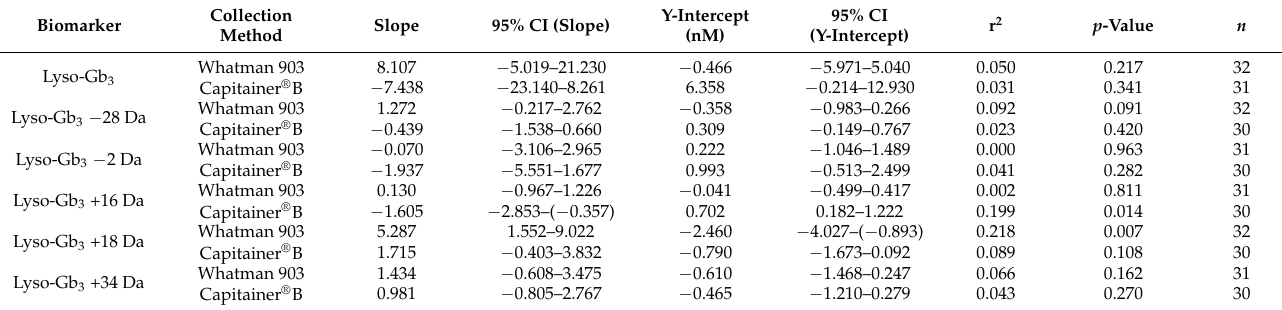
Table 12. Simple linear regression parameters of the difference between DBSs and plasma biomarker measurements as a function of hematocrit for lyso-Gb 3 and related